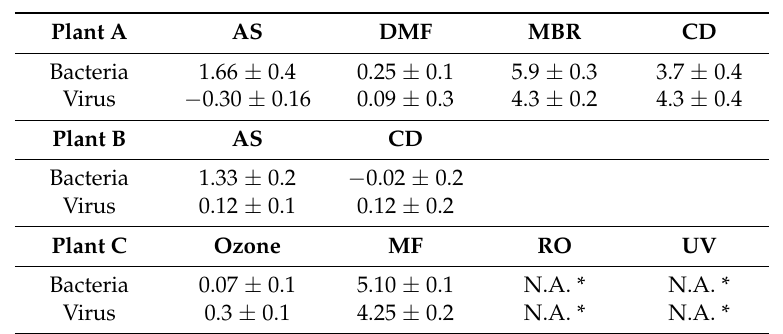
Summary of log 10 removal efficiency of bacteria and viruses in different water reclamation